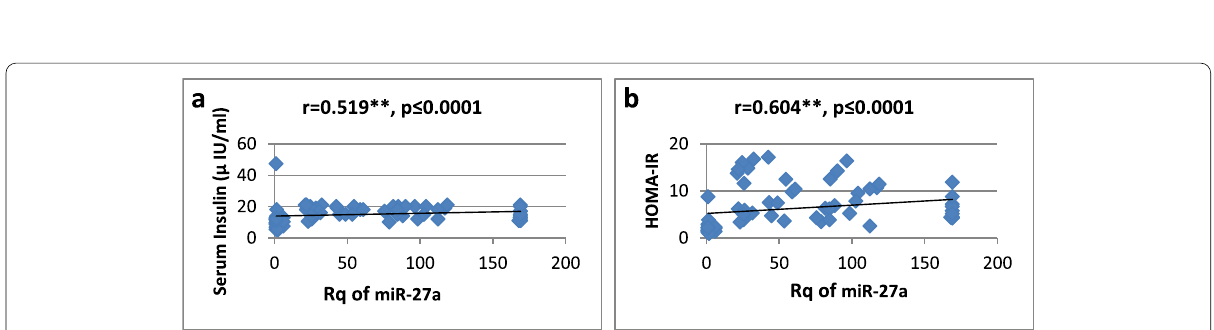
Fig. 5 a , b Correlation coefficient between Rq of MicroRNA 27‑a and both serum insulin ( r significant at